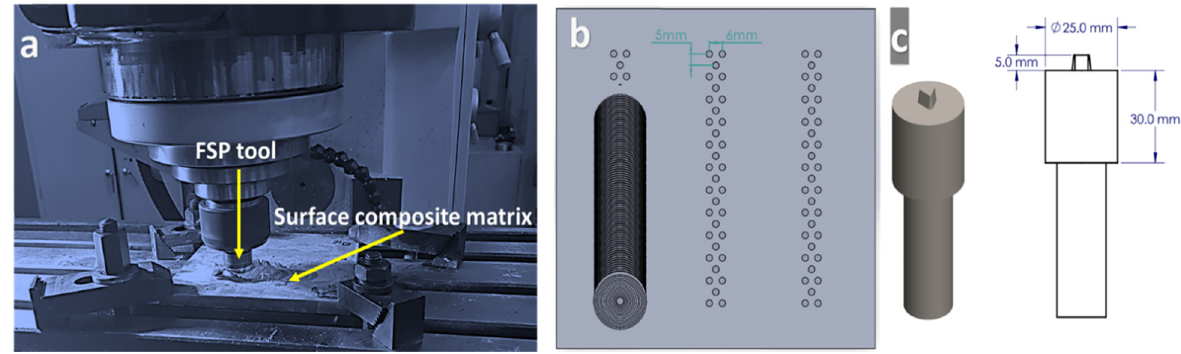
Figure 1: FSP: ( a ) experimental setup using a milling machine, ( b ) schematic drawing of the holes before and after FSP, and ( c ) FSP tool